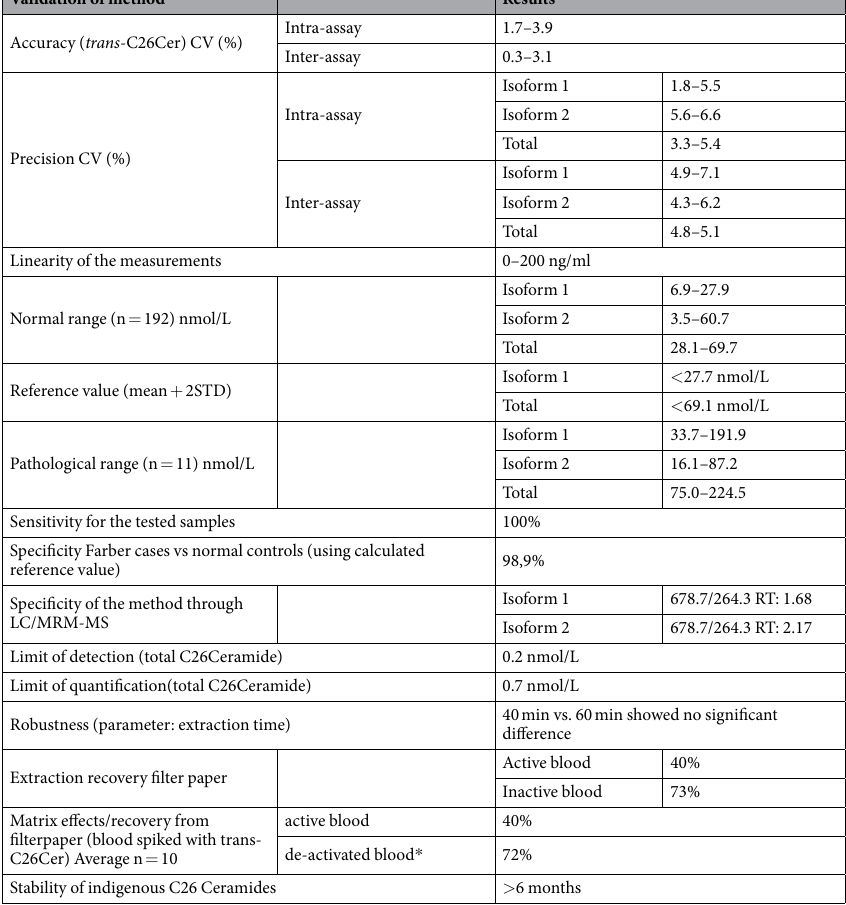
Table 3. Quantification of C26:0 ceramides in dried blood spots - summary of the assay characteristics. De- activated blood samples were prepared as described elsewhere 55